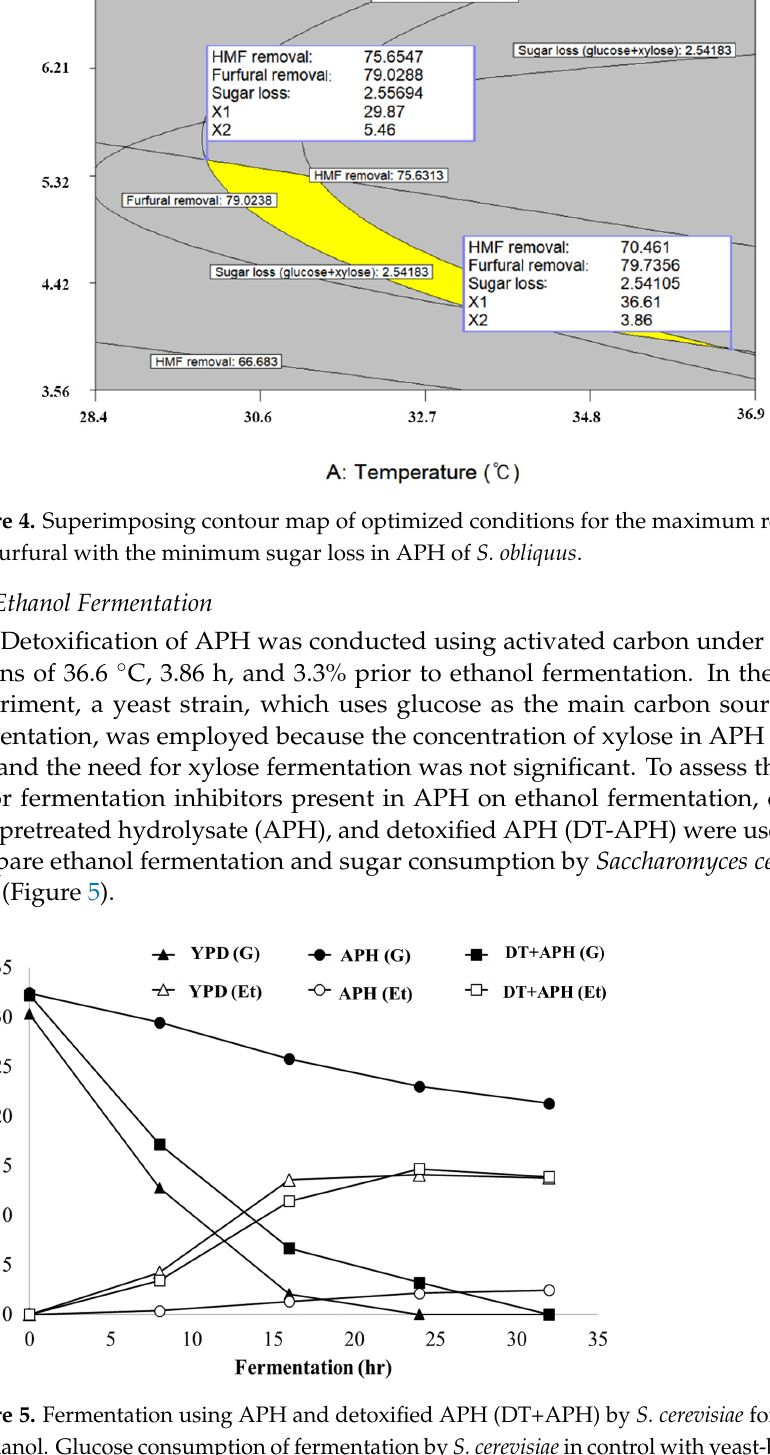
the optimal value using the second-order regression models was valid for the optimization of a detoxification process using activated carbon.